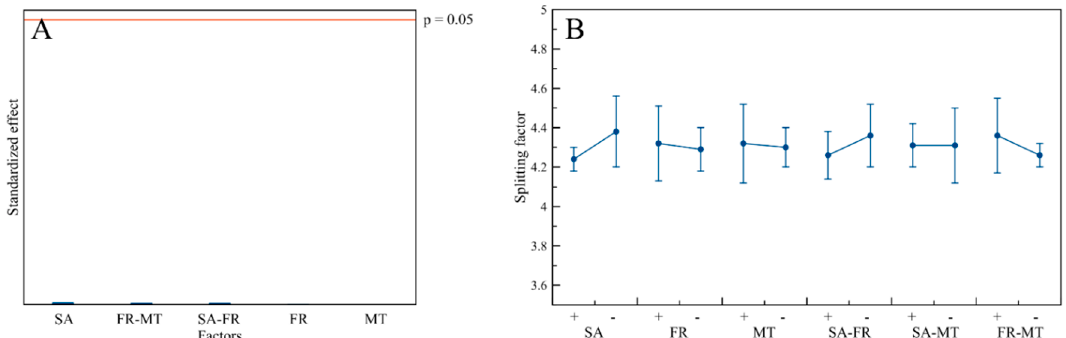
Figure 6. ( A ) Pareto chart of relevant standardized effects at the confidence limit of 95% and ( B ) plot of marginal means for the splitting factor.